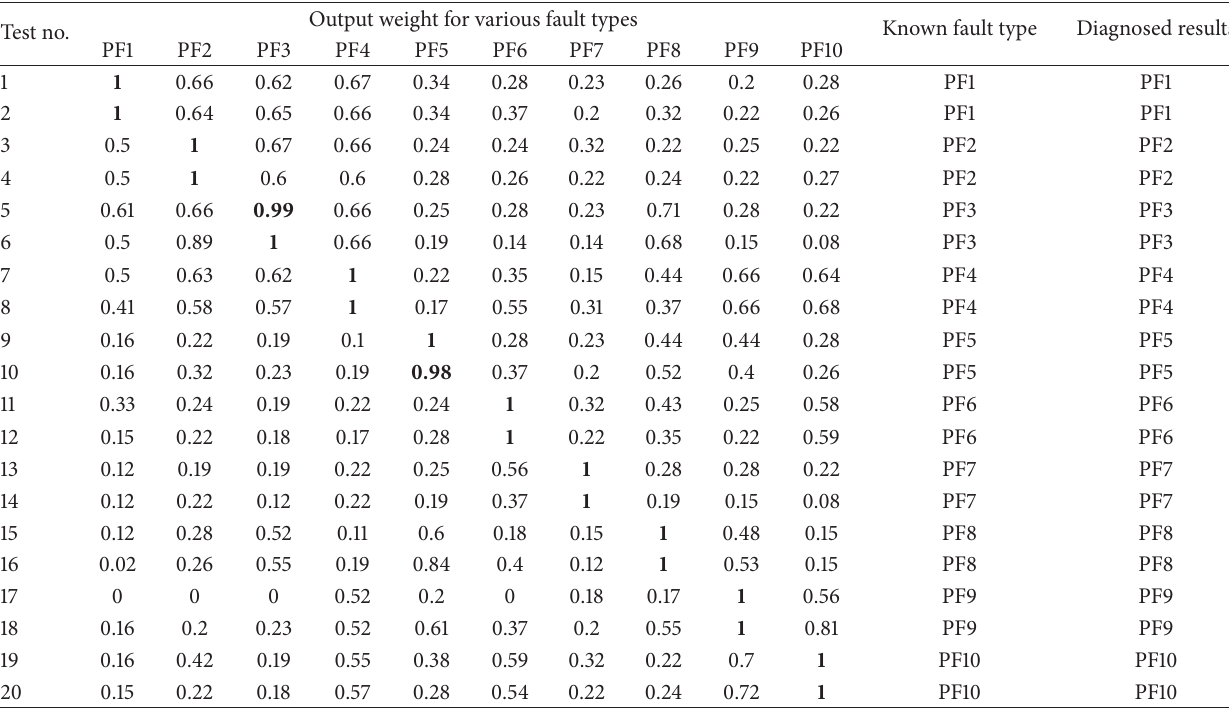
Table 7: Diagnosis results of the test data under 300–1000 W/m 2 irradiation and PV module surface temperatures between 51 and 60 ∘ C. Test